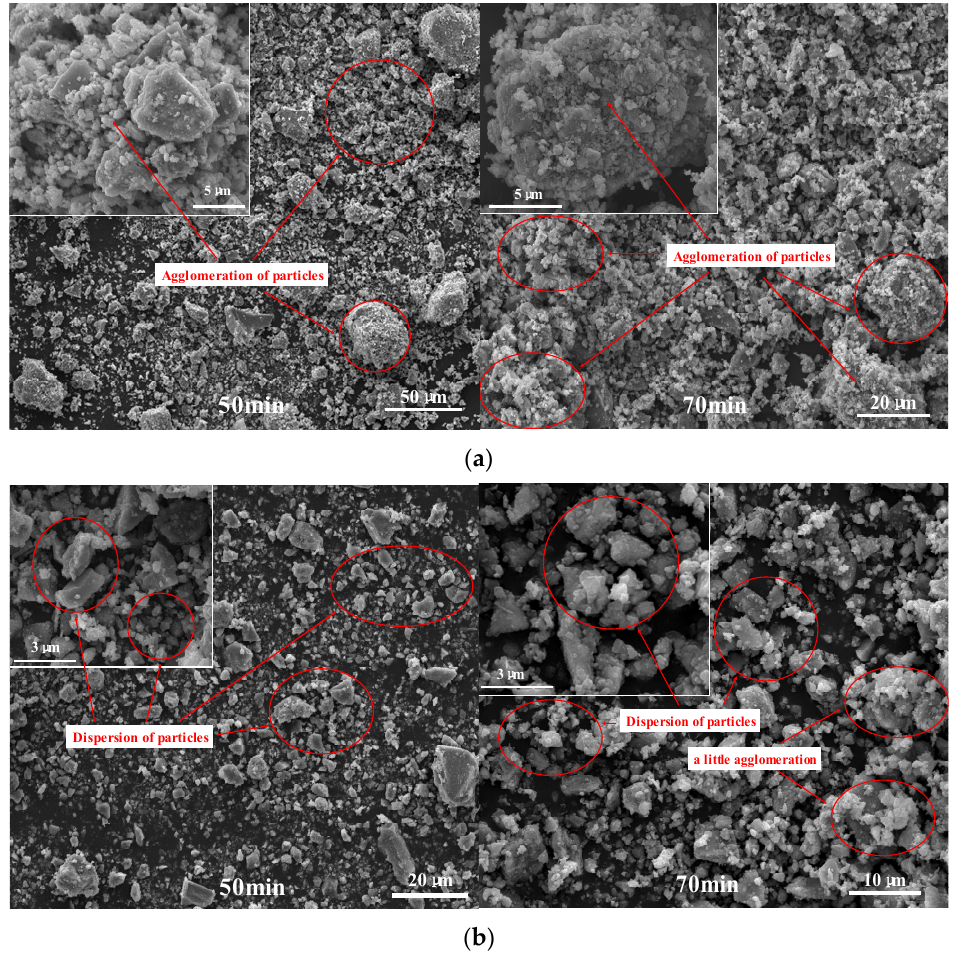
Figure 12. Particle morphologies of steel slag powder with and without GA: ( a ) without GA; ( b ) with GA.